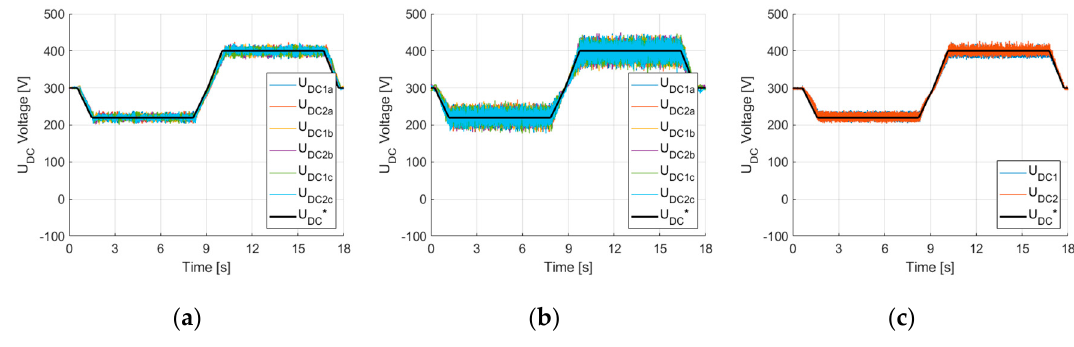
Figure 10. Capacitor DC-link voltages: ( a ) CHB (4000 𝜇𝐹) ; ( b ) CH (1200 𝜇𝐹); ( c ) CHB-SDC (1200 𝜇𝐹) .